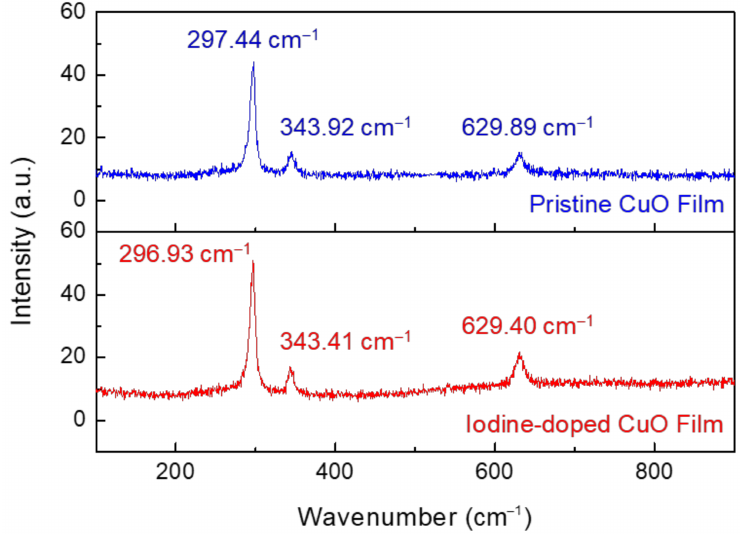
Figure 5. Raman spectra of pristine and iodine-doped CuO